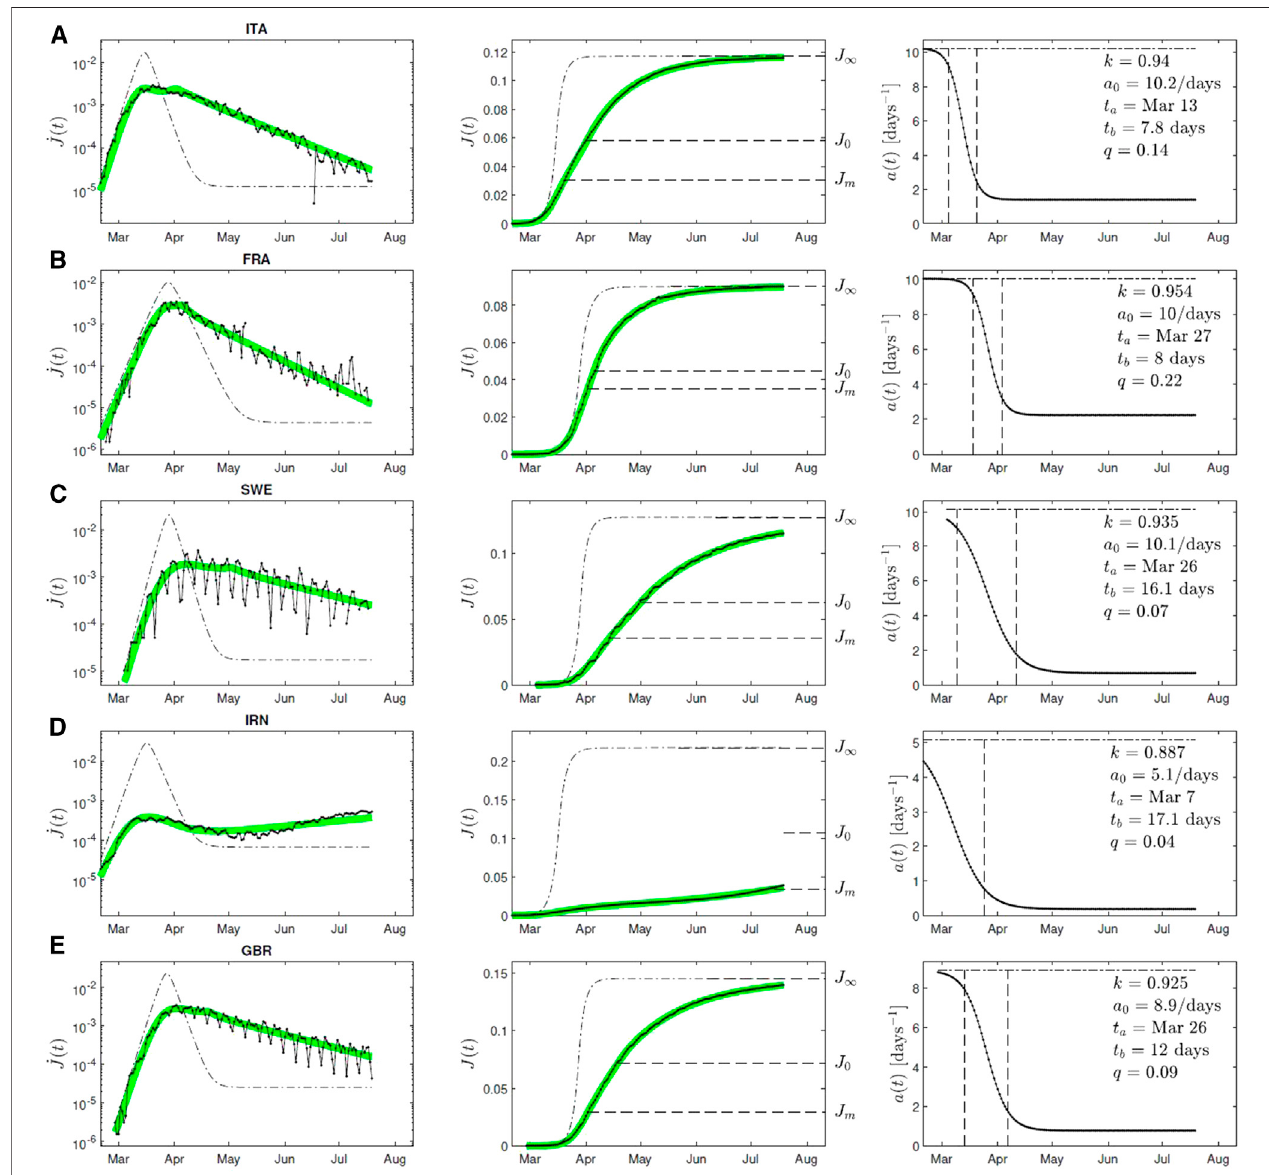
FIGURE 6 | Same as Figure 5 for other countries: (A) Italy (ITA), (B) France (FRA), (C) Sweden (SWE), (D) Iran (IRN), (E) Great Britain